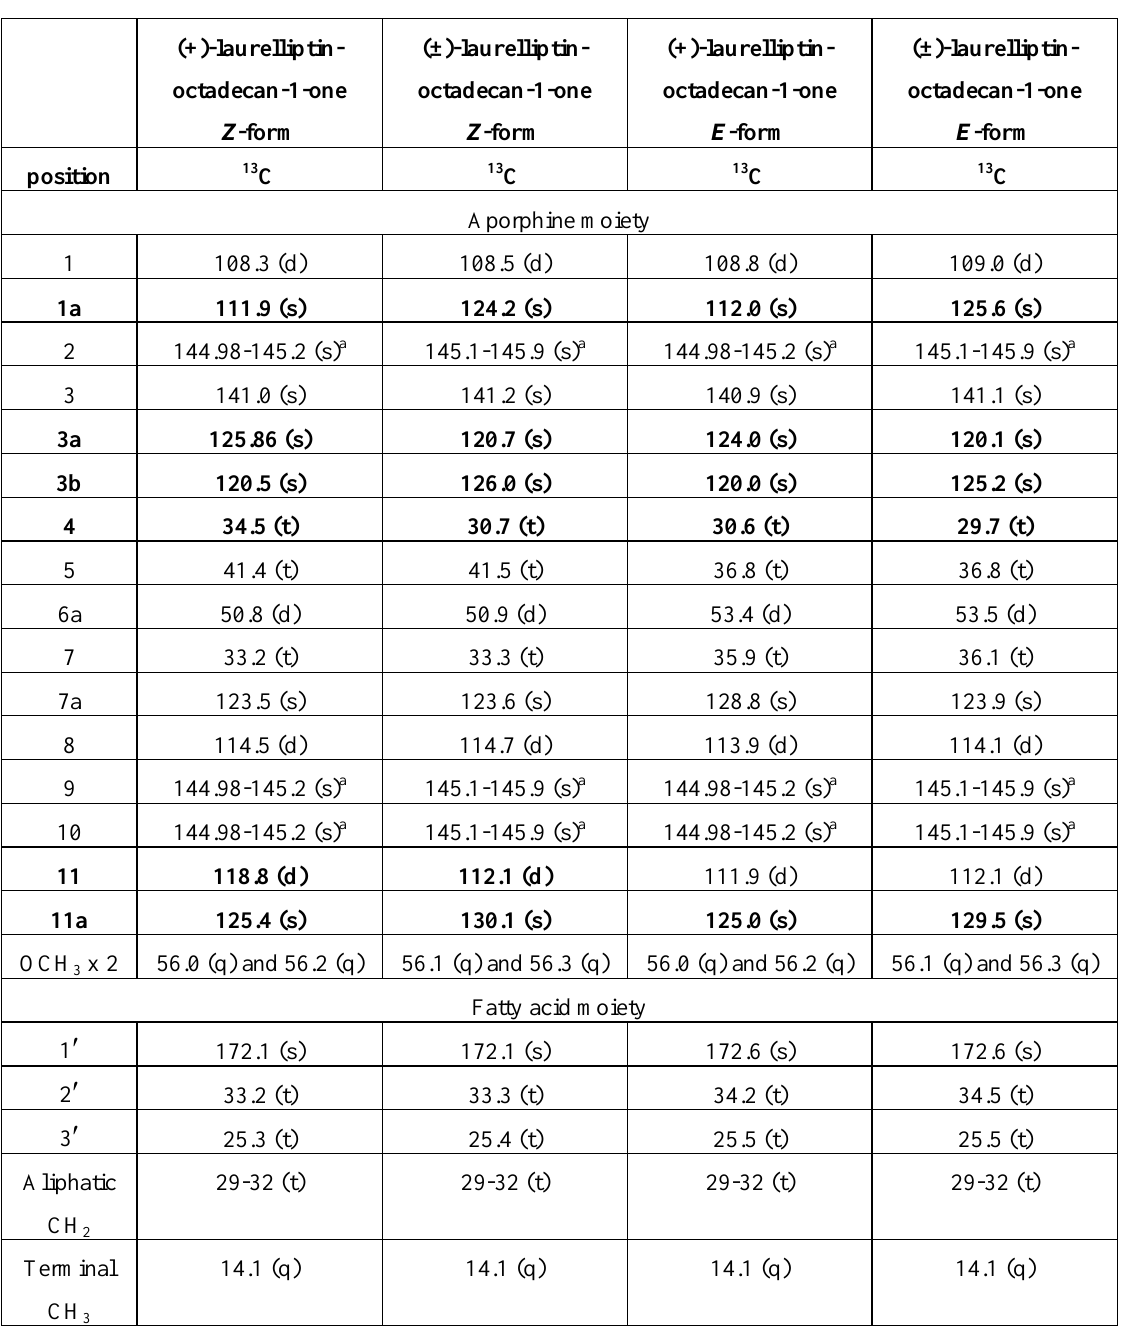
Table 4. Comparison of 13 C-NMR spectral data between (+)-laurelliptinoctadecan-1-one (150 MHz, CDCl ) and (±)-laurelliptinoctadecan-1-one (75 MHz, CDCl 3